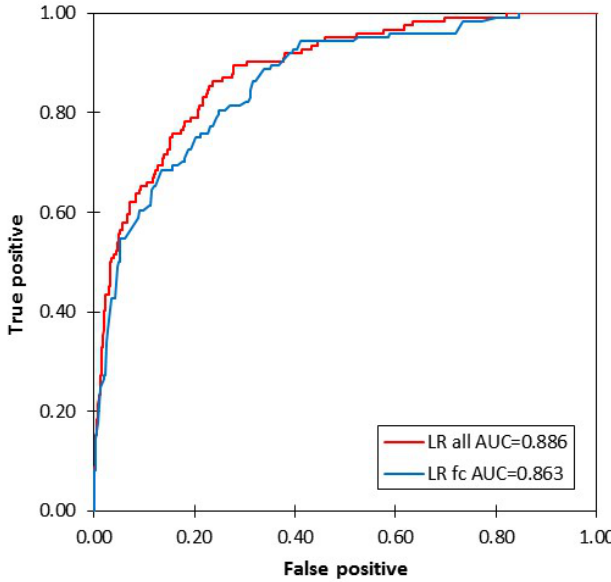
Figure 5. ROC curves of the models produced with the corresponding areas under the curves (AUC). Legend: LR all—Logistic regression with all factors; LR fc—Logistic regression forward